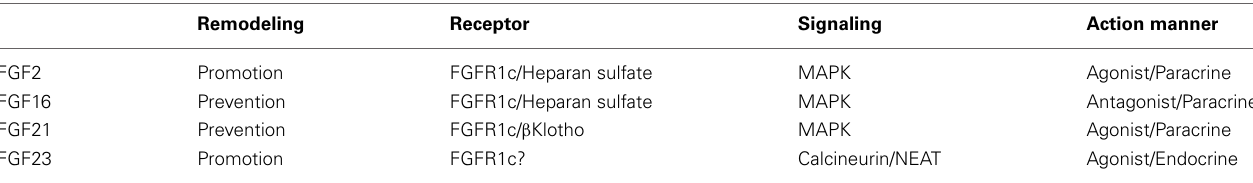
Table 1 | Roles of FGFs 2, 16, 21, and 23 in cardiac